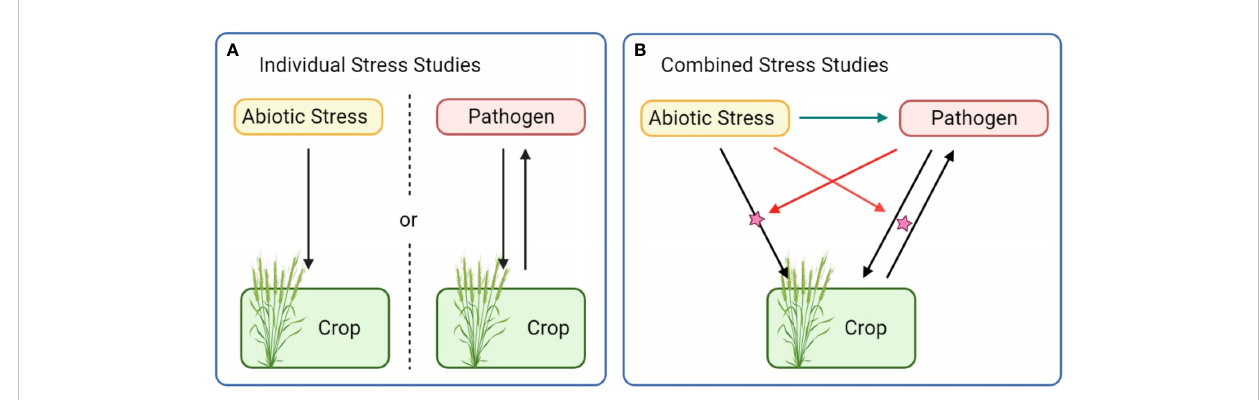
FIGURE 1 In single stress studies (A) , the effect of stressors is dissected independently of other sources of variation. Holistic assessment of combined stress (B) requires to account for a supplementary stressor and supplementary effects (colored